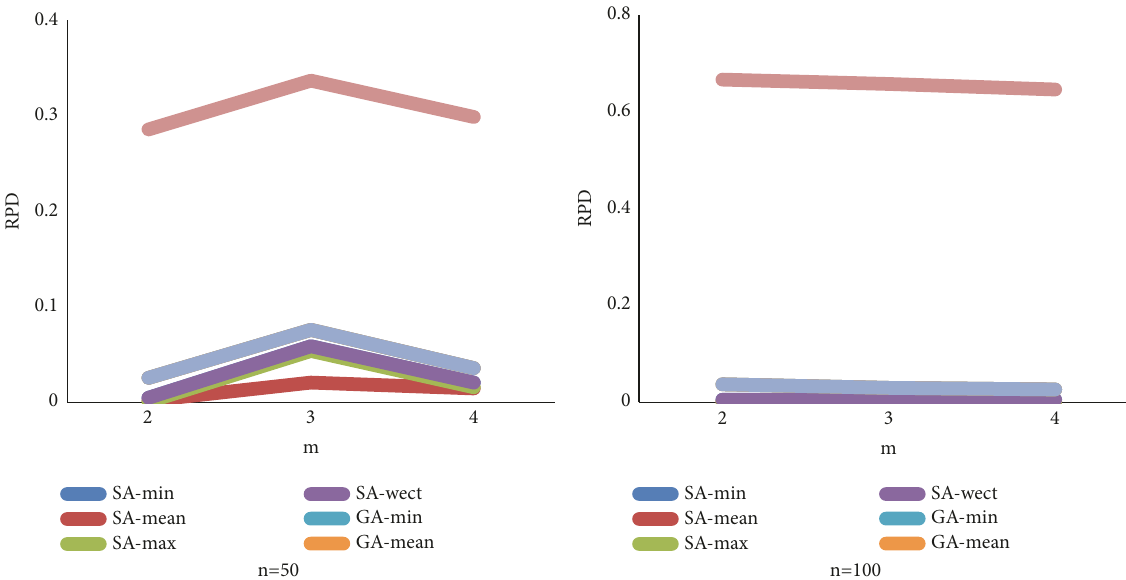
Figure 3: Change of RPD for each 𝑛 as 𝑚 increases for SAs and GAs for large number of